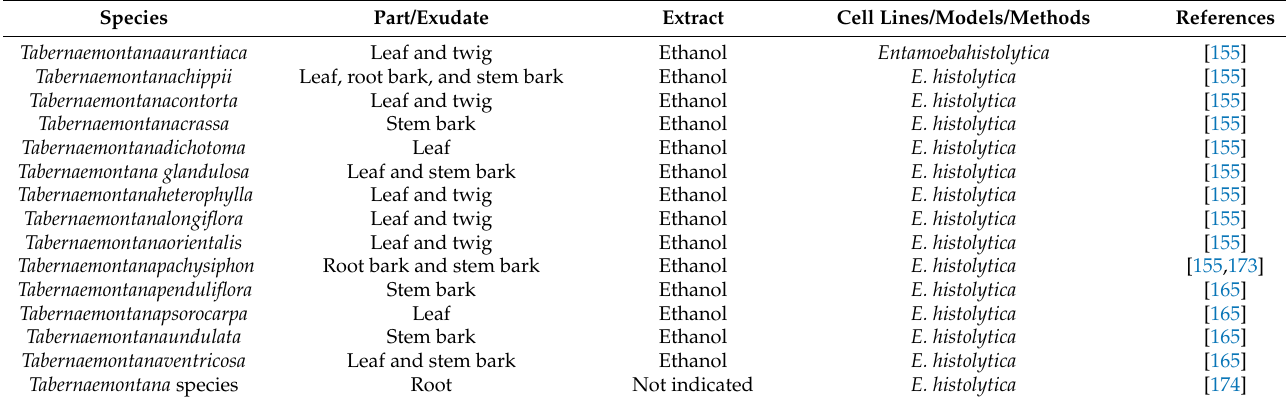
Table 7. Antiamoebic activities of extracts and compounds isolated from Tabernaemontana species. Species Part/Exudate Extract Cell